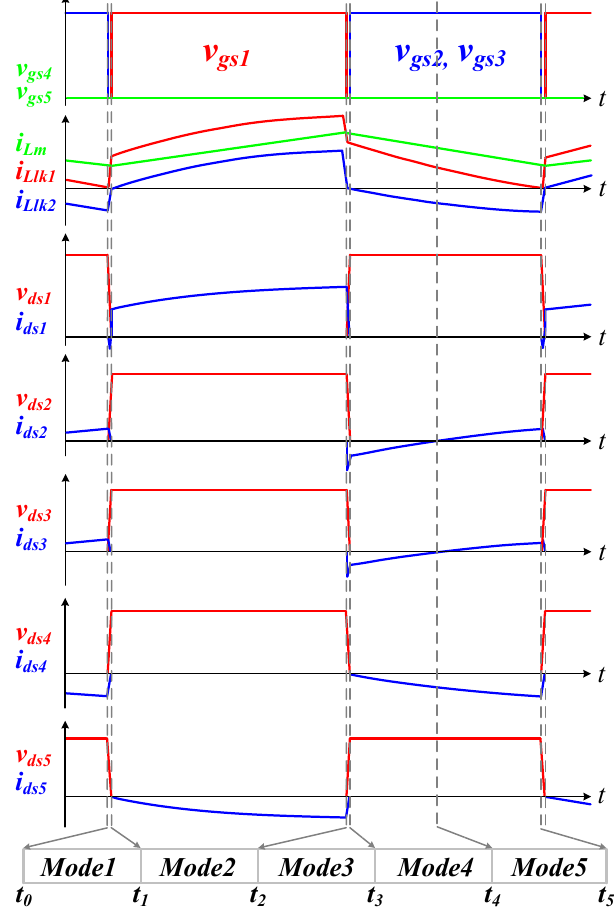
Figure 3. Key waveforms of the proposed topology in the step-up mode.